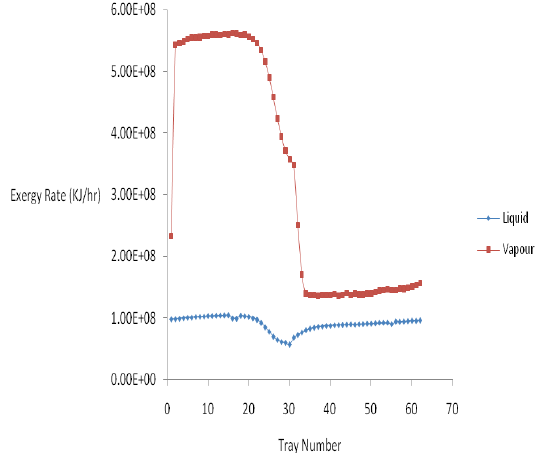
Figure 23. Profile of exergy rate versus tray number for Depropanizer of base case, Reflux Ratio 6